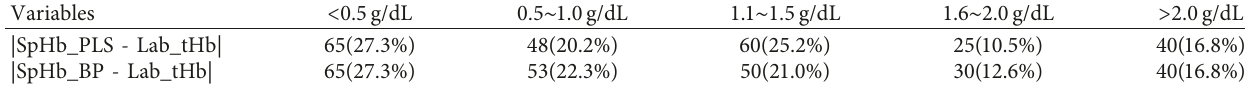
Table 2: Groups based on differences between noninvasive (SpHb) and laboratory reference Hb values (tHb). Variables